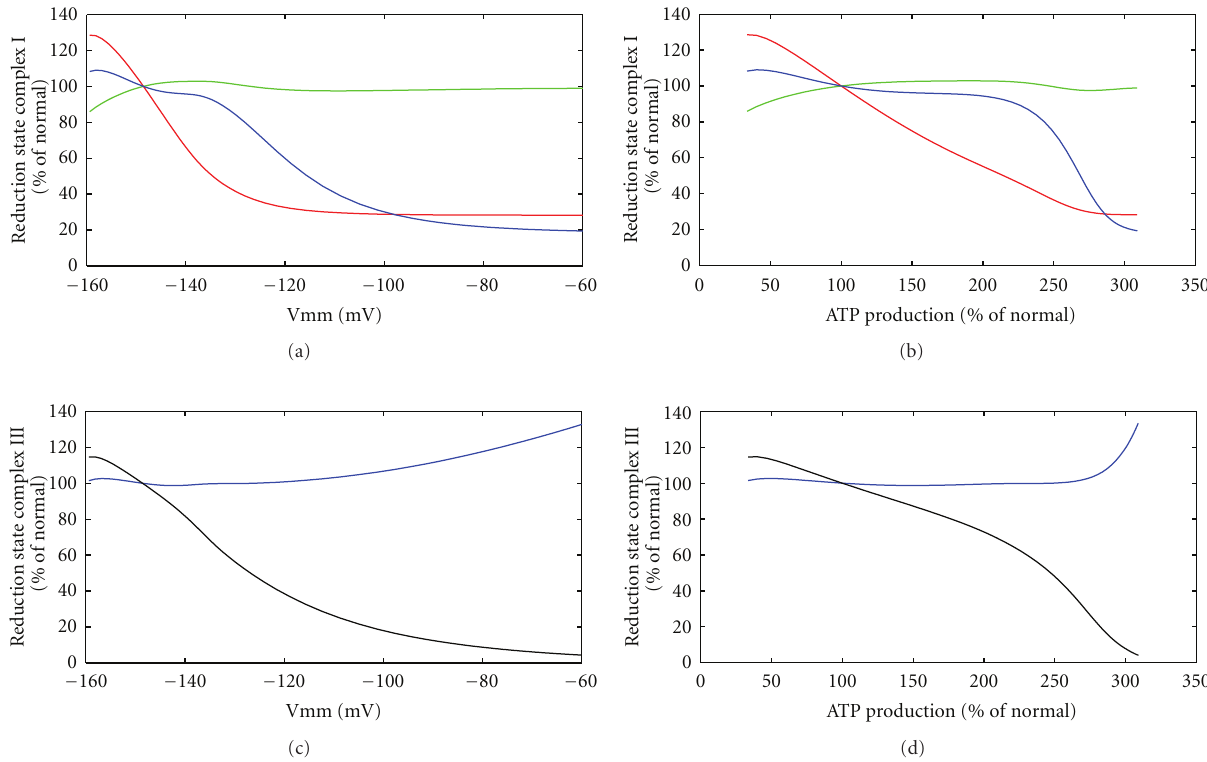
Figure 5: Potential ROS producing states in the RC. ROS producing states of complex I ((a) and (b)) and complex III ((c) and (d)) are depicted versus the mitochondrial membrane potential ((a) and (c)) or the ATP production rate. Red: fully reduced flavin, green: flavin radical, blue: semi-ubiquinon at n-site bound to the respective complex, black: semi-ubiquinon at p-site bound to complex III. ATP production and occupation of ROS producing states are normalized to the reference state of the system.